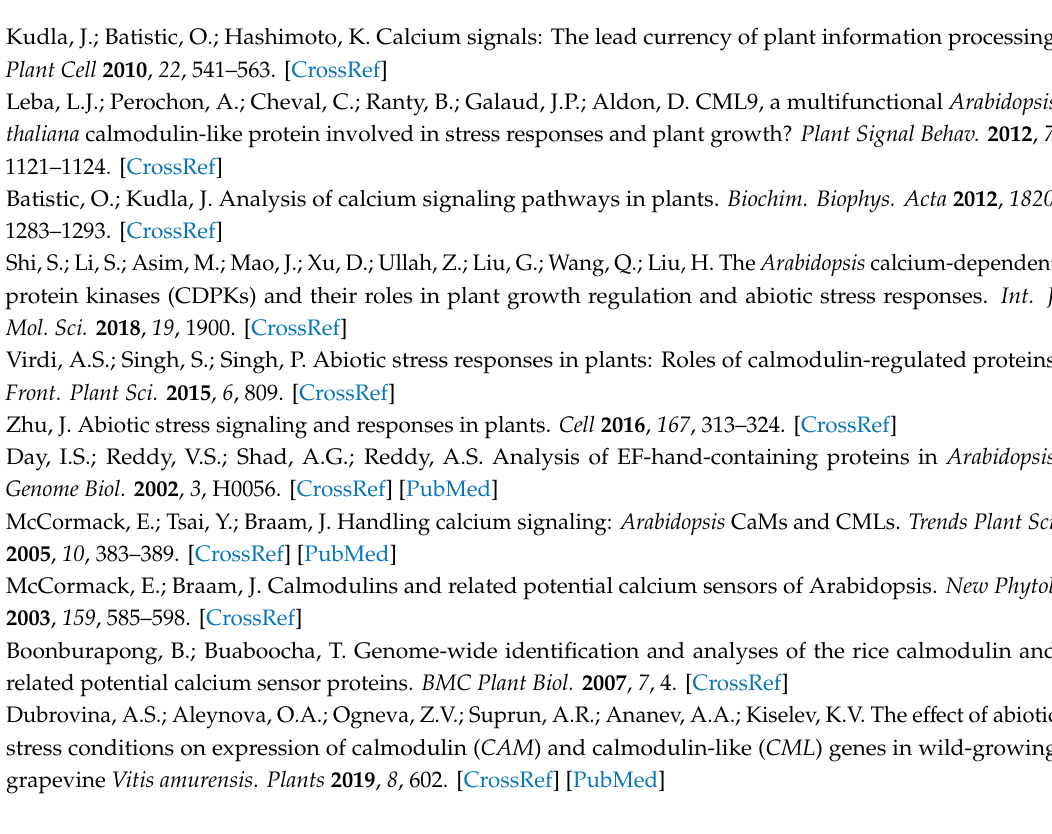
Table S1. The CML protein sequence in Medicago truncatula . Table S2. The expression pattern of MtCML genes in di ff erent developmental tissues of Medicago truncatula . Table S3. The expression level of the MtCML genes under salt and drought stresses from the microarray data. Table S4. The relative expression of MtCML genes in cold treatment. Table S5. The promoter information of MtCML genes. Table S6. Sequences of primers used in qRT-PCR. Table S7. The percentages of identity between pairs of paralogous MtCML